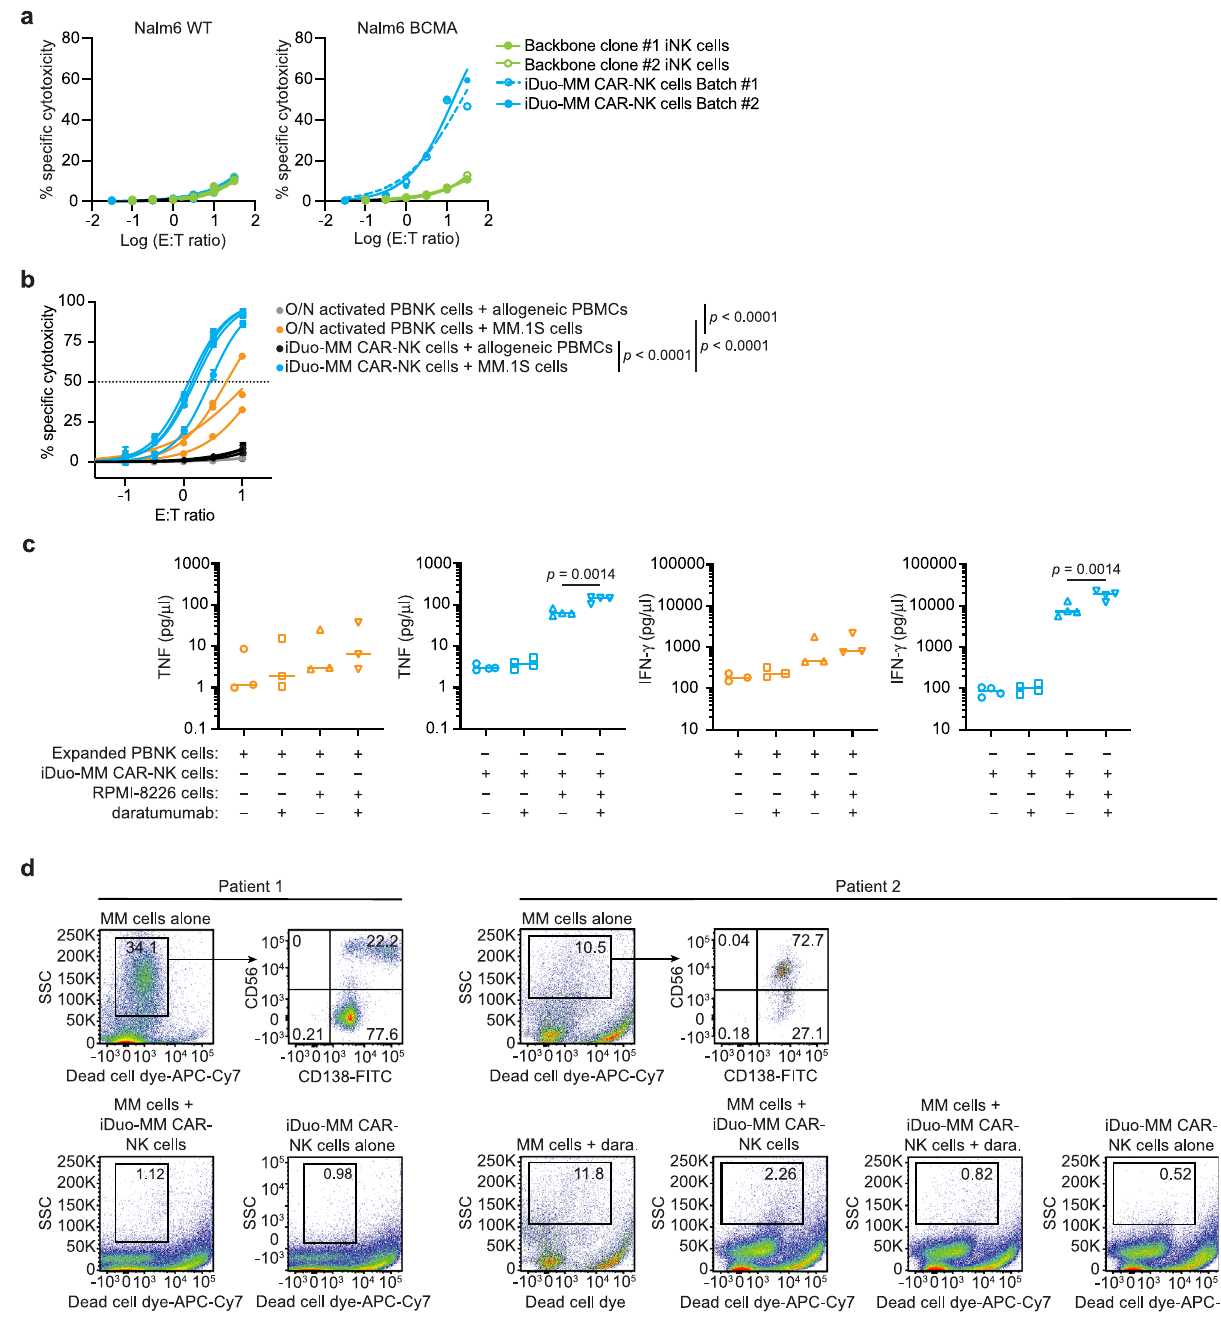
Fig. 3 | iDuo-MM CAR-NK cells exhibit robust speci fi c cytotoxicity and enhanced in fl ammatory cytokine production when combined with dar- atumumab. a Two independent batches of iDuo-MM CAR-NK cells were assessed alongside iNK cells differentiated from backbone clones 1 and 2 for BCMA-speci fi c cytotoxicity. Nalm6 cells overexpressing BCMA were mixed at a 1:1 ratio with WT Nalm6lackingBCMAandusedastargetsina4-hourcytotoxicityassayatE:Tratios ranging from 0.03:1 to 31:1. Speci fi c cytotoxicity was calculated independently for BCMA-negative WT Nalm6 cells (left) and BCMA-engineered Nalm6 cells (right) as the frequencies of target cells with active caspase-3/7 activity by fl ow cytometry. Data are from two independent experiments. b iDuo-MM CAR-NK cells from four independent differentiations and overnight (O/N) primed (10ng/ml IL-15) PBNK cellsisolatedfromthreehealthydonorswereco-culturedwithamixtureofnormal donorPBMCsandMM.1Smyelomacells.Speci fi